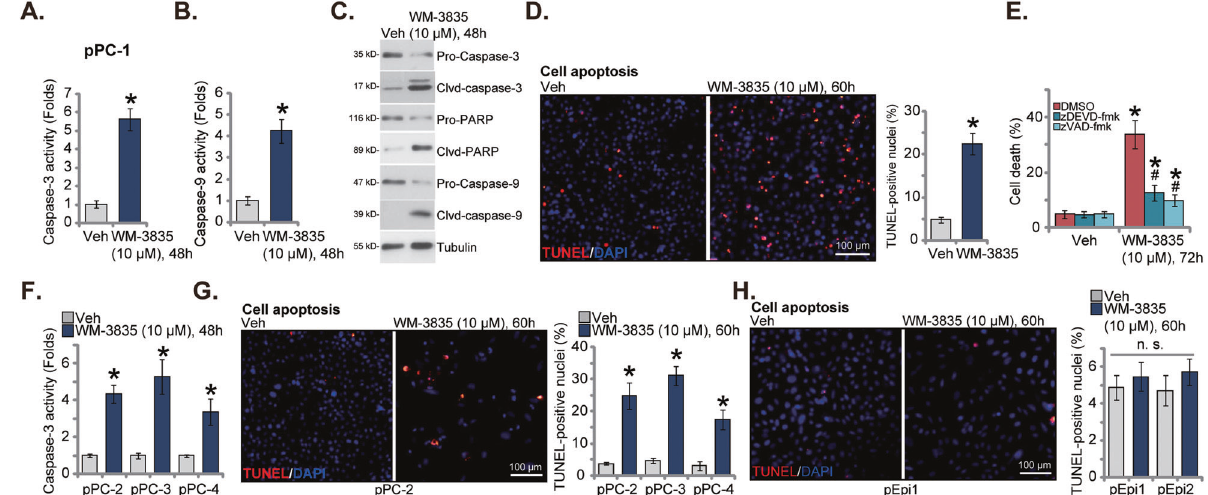
Fig. 2 WM-3835 provokes apoptosis in primary CRPC cells. The primary human prostate cancer cells derived from a CRPC patient, “ pPC-1 ” , were treated with WM-3835 (10 μ M) or vehicle control ( “ Veh ” ) for designated hours, caspase-PARP activation was measured ( A – C ); Cell apoptosis was tested by nuclear TUNEL staining assay ( D ). pPC-1 cells were pretreated with zDEVD-fmk (45 μ M), zVAD-fmk (45 μ M), or DMSO (0.1%) for 1 h, followed by WM-3835 (10 μ M) treatment for another 72 h, cell death was tested by LDH releasing assay ( E ). The primary human prostate cancer cells derived from three other CRPC patients, “ pPC-2/pPC-3/pPC-4 ” ( F , G ), or the primary human prostate epithelial cells ( “ pEpi1 ” and “ pEpi2 ” , derived from two patients) ( H ) were treated WM-3835 (10 μ M) or vehicle control ( “ Veh ” ) for designated hours, caspase-3 activity ( F ), and apoptosis ( G , H ) were tested using the similar methods. Data were expressed as the mean ± standard deviation (SD, n = 5). * P < 0.05 versus “ Veh ” group. # P < 0.05 versus “ DMSO ” treatment ( E ). “ n. s. ” stands for non-statistical difference ( P > 0.05). Scale bar = 100 μ